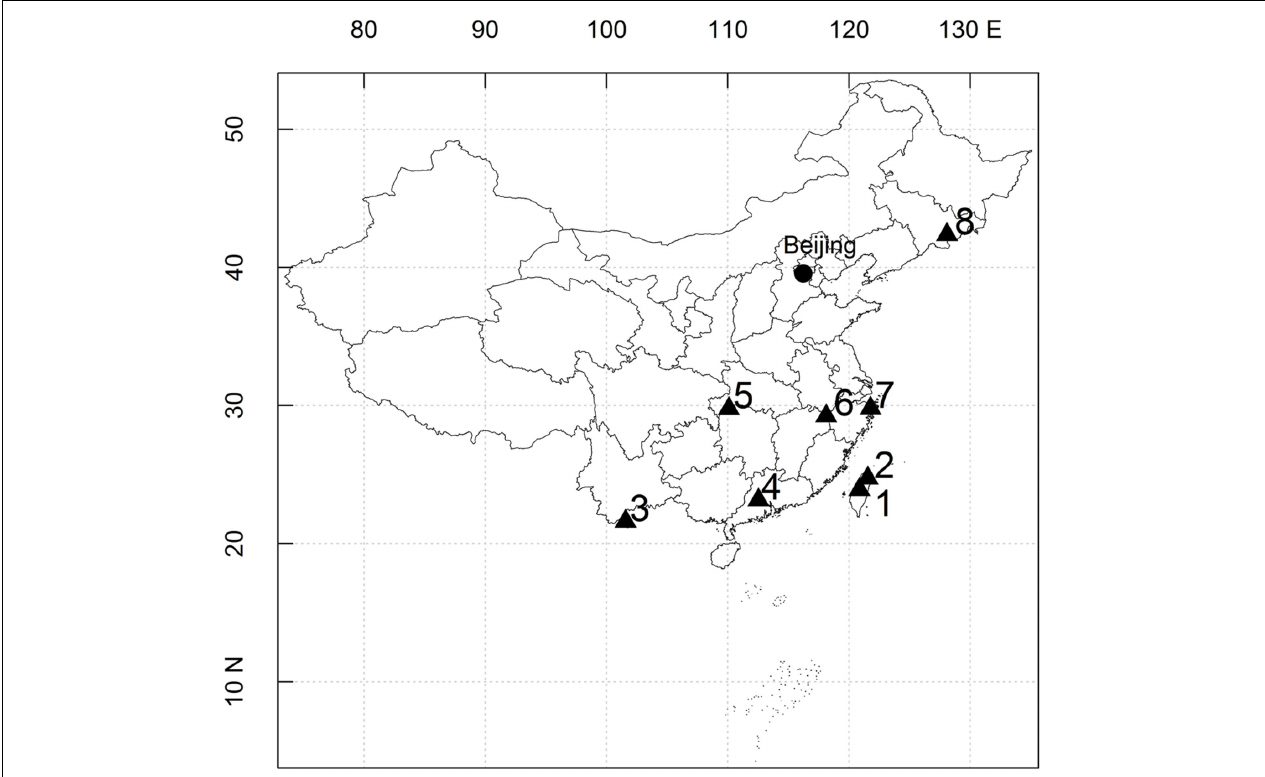
FIGURE 1 | Location of eight dynamics plots in East Asia. (1) Lianhuachi plot; (2) Fushan plot; (3) Xishuangbanna plot; (4) Dinghushan plot; (5) Badagongshan plot; (6) Gutianshan plot; (7) Tiantongshan plot; (8) Changbaishan plot.